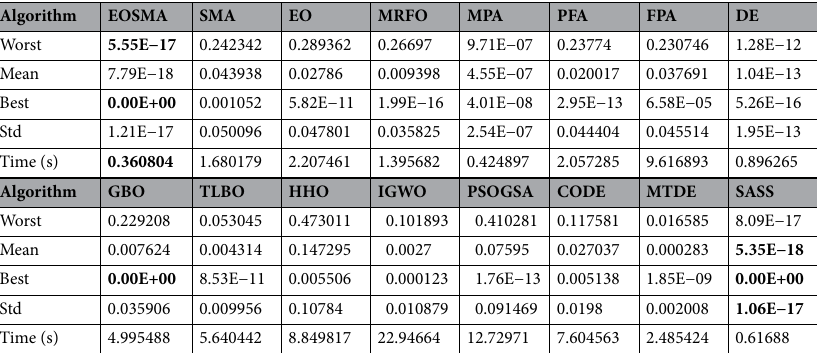
Table 7. Optimization results take into account the posture of the end-effector. The optimal values are shown in bold.